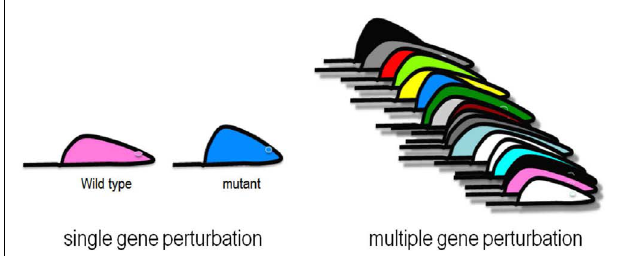
FIGURE 2 | Genetic analysis of complex traits . Single gene perturbations such as Mendelian traits and knockout mouse models involve two states where causality is easy to establish. Collections of strains of mice, or randomly sampled people, are examples of multiple gene perturbations, which involve many states where interactions can be studied using correlation and network modeling.